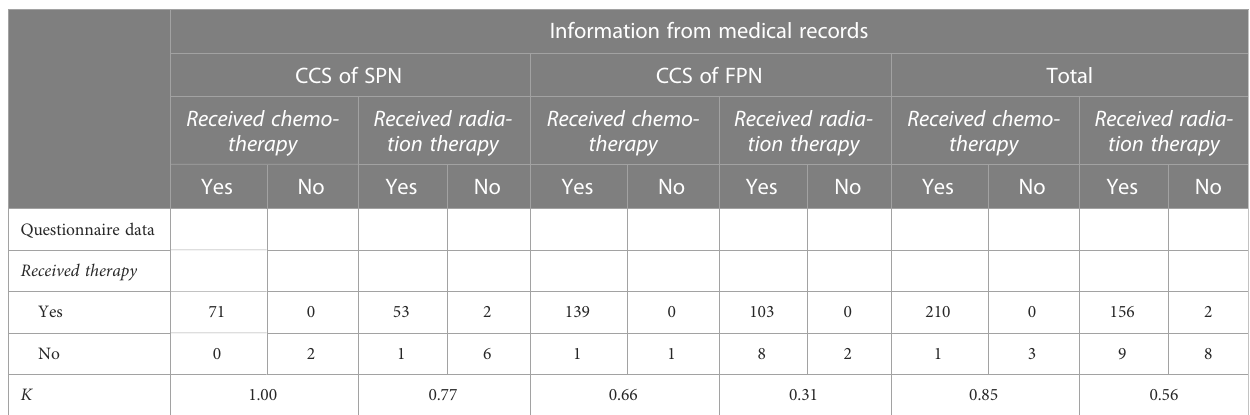
TABLE 3 Concordance between self-reported exposure to cancer therapies and data from medical